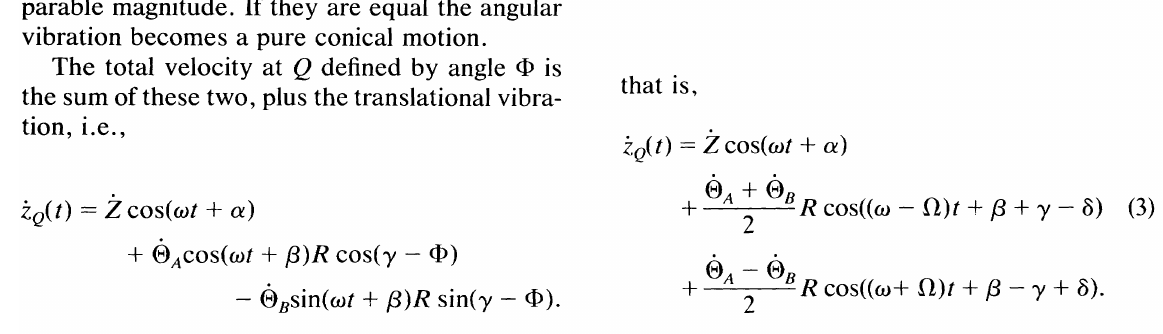
FIGURE 6 2-Dimensional Angular Displacement of a Moving Surface.